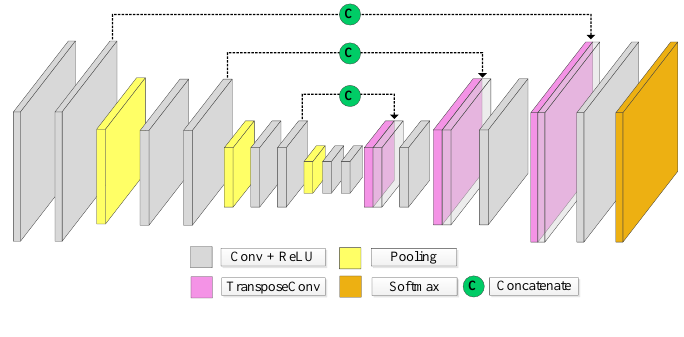
Figure 3. U-Net architecture.